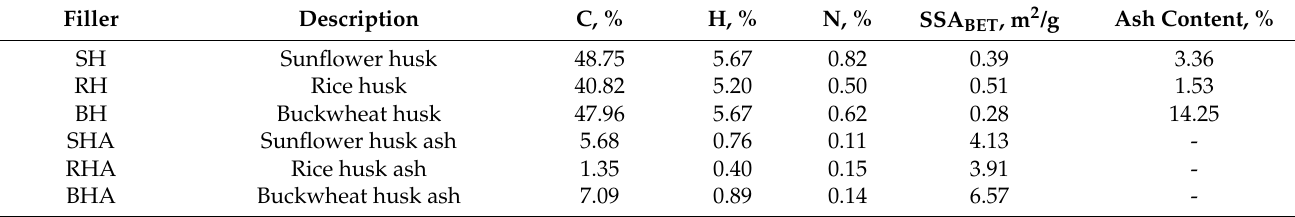
Table 1. Chemical composition and specific surface area of the